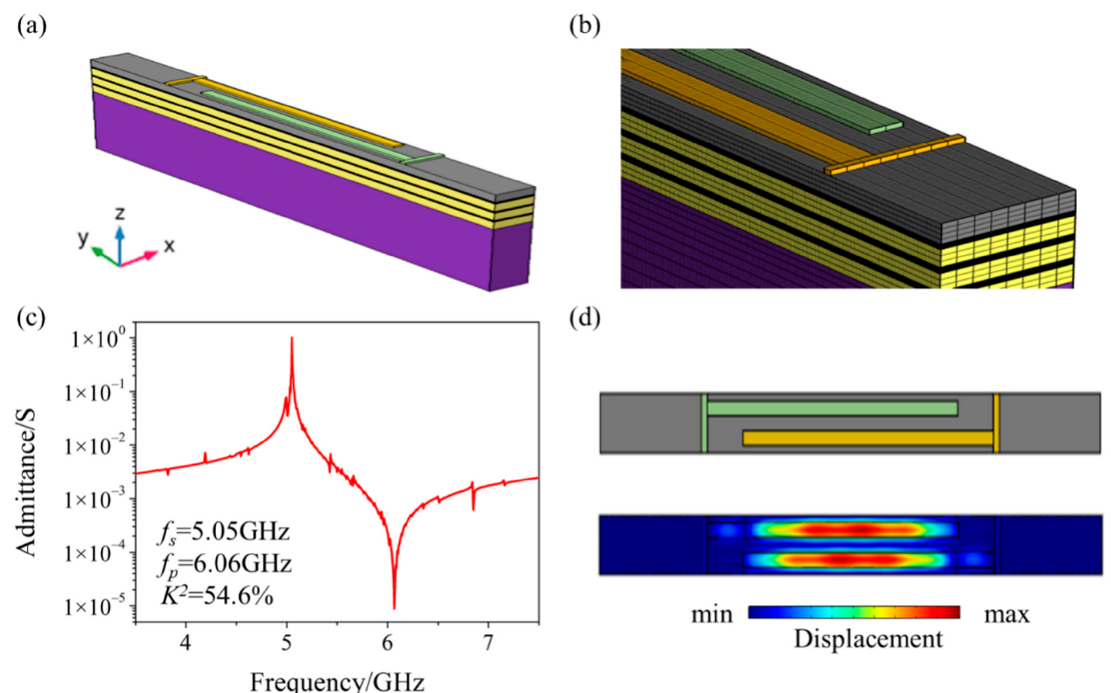
Figure 5. 3D simulation of the SM-YBAR. ( a ) 3D schematic diagram; ( b ) Finite element meshing; ( c ) calculated admittance; ( d ) Top view and the BAW field distribution at its resonance frequency.